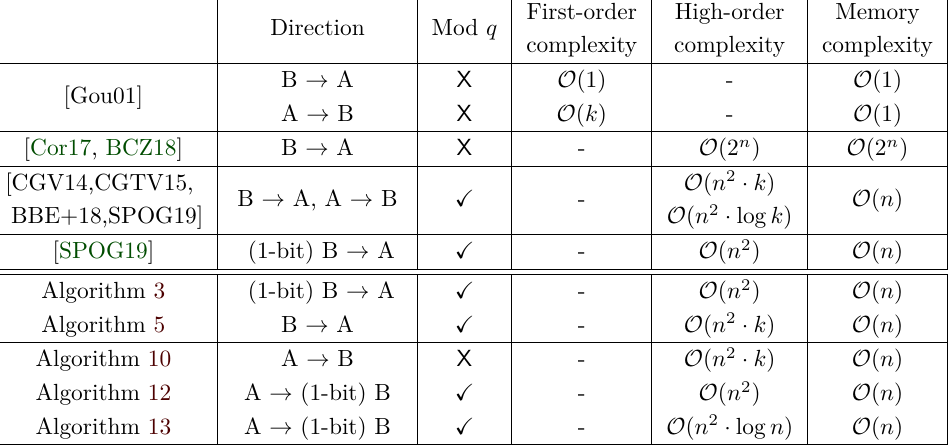
Table 1: Complexities of Boolean vs arithmetic conversions in both directions, for first- order attacks, and for high-order attacks with n shares. For all algorithms the complexity is for k -bit register, except for Algorithm 12 which uses 2 k -bit registers. We indicate the Mod q property when the arithmetic masking can be modulo any q , not only modulo 2 k